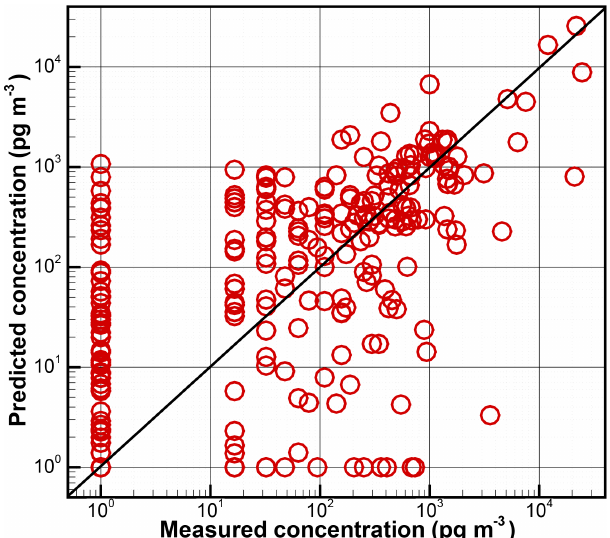
Figure 2. Comparison between the predicted and measured con- centrations for release 2 during the CAPTEX experiment. In the HYSPLIT simulation, at the exact release location, an emission rate of 67kgh − 1 was applied from 17:00 to 20:00Z on 25 Septem- ber 1983. A constant 1pgm − 3 is added to both predicted and mea- sured concentrations to allow logarithm